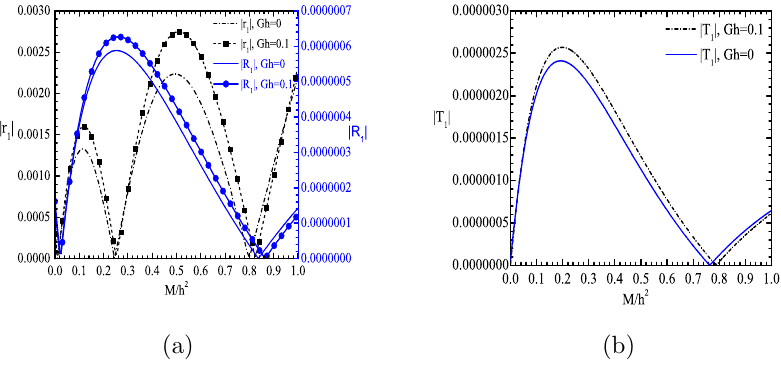
Figure 6. Coefficients due to incident wave of mode λ 1 in (a) | r 1 | and | R 1 | ; (b) | T 1 | for ρ = 0 . 5, H/h = 2, Kh = 0 . 5, γh = 1, a/h = 0 . 1, m = 5 ,n = 3. The effect of the surface tension on the first order reflection and transmission coefficients due to incident wave of both modes is shown in Figure 6(a)–(b) and Figure 7(a)–(b).